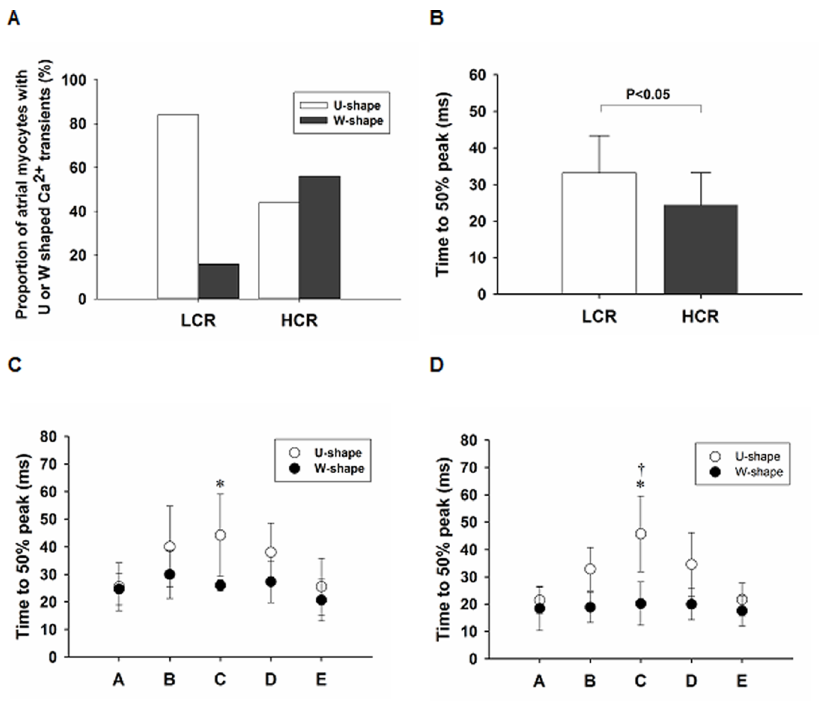
Figure 8. Analysis of transverse linescan Ca 2 + signal in isolated atrial myocytes. A, Proportion of cells with different Ca 2 + response pattern (U- or W-shaped). B, Time to 50% peak Ca 2 + release in Low Capacity Runner (LCR) vs. High Capacity Runner (HCR) rats. C and D, Spatial characteristics of time to 50% peak Ca 2 + release in U- vs W shaped transients in LCR and HCR. Data are mean 6 SD. Difference in time to 50% peak Ca 2 + release between edges (A and E, x-axis) and center (C, x-axis) in U shaped transient: * p , 0.05. Difference in time to 50% peak Ca 2 + release between central region of U- and W-shaped transient: { p , 0.05. Data are presented as mean 6 SD. n=19 cells for LCR and 16 cells for HCR.